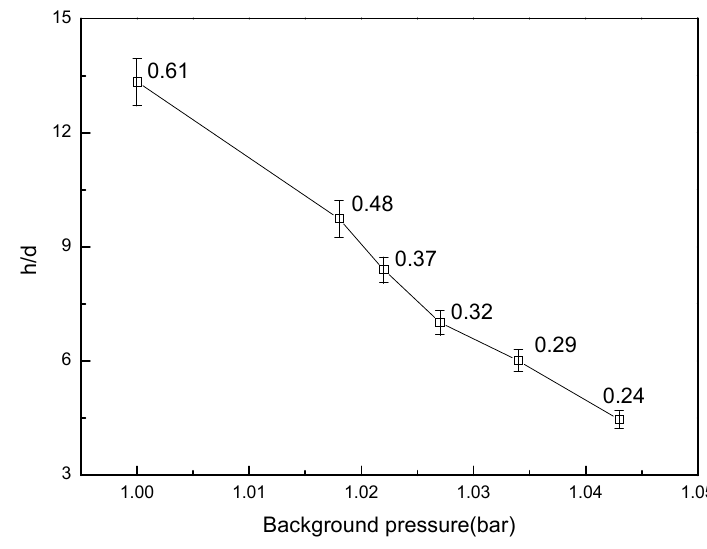
Figure 7. Lift-off height at different background pressures.